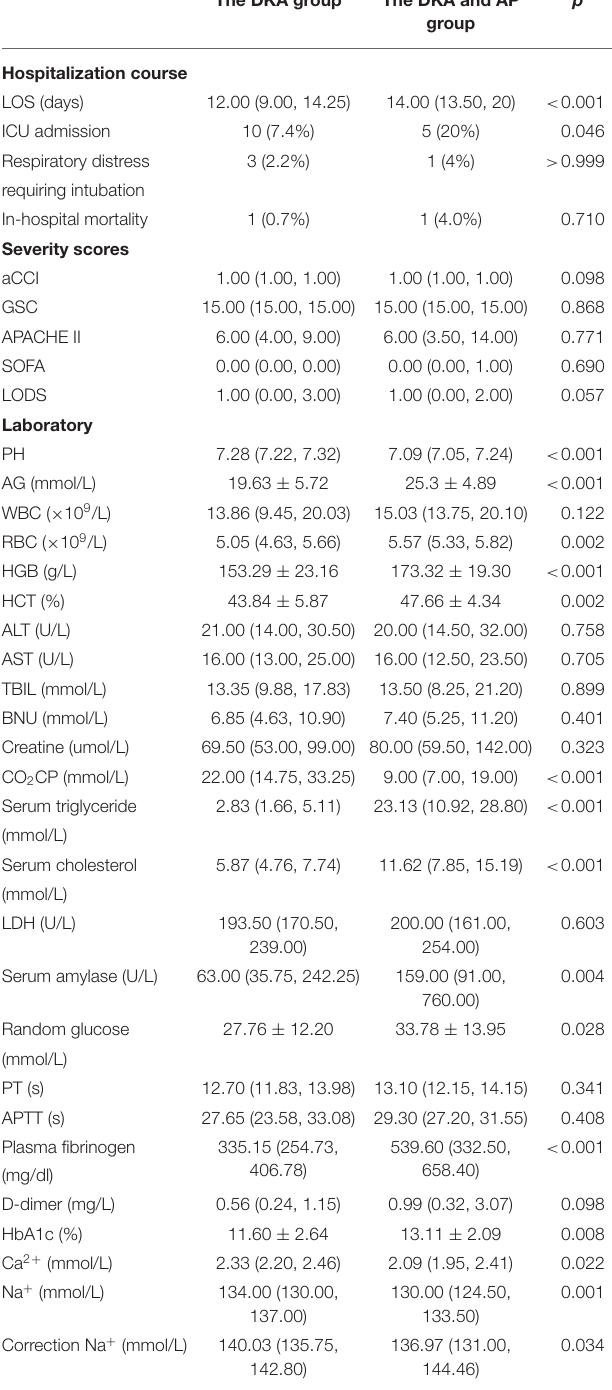
TABLE 2 | Comparison of clinical and biochemical results in DKA patients with and without AP. The DKA group The DKA and AP group